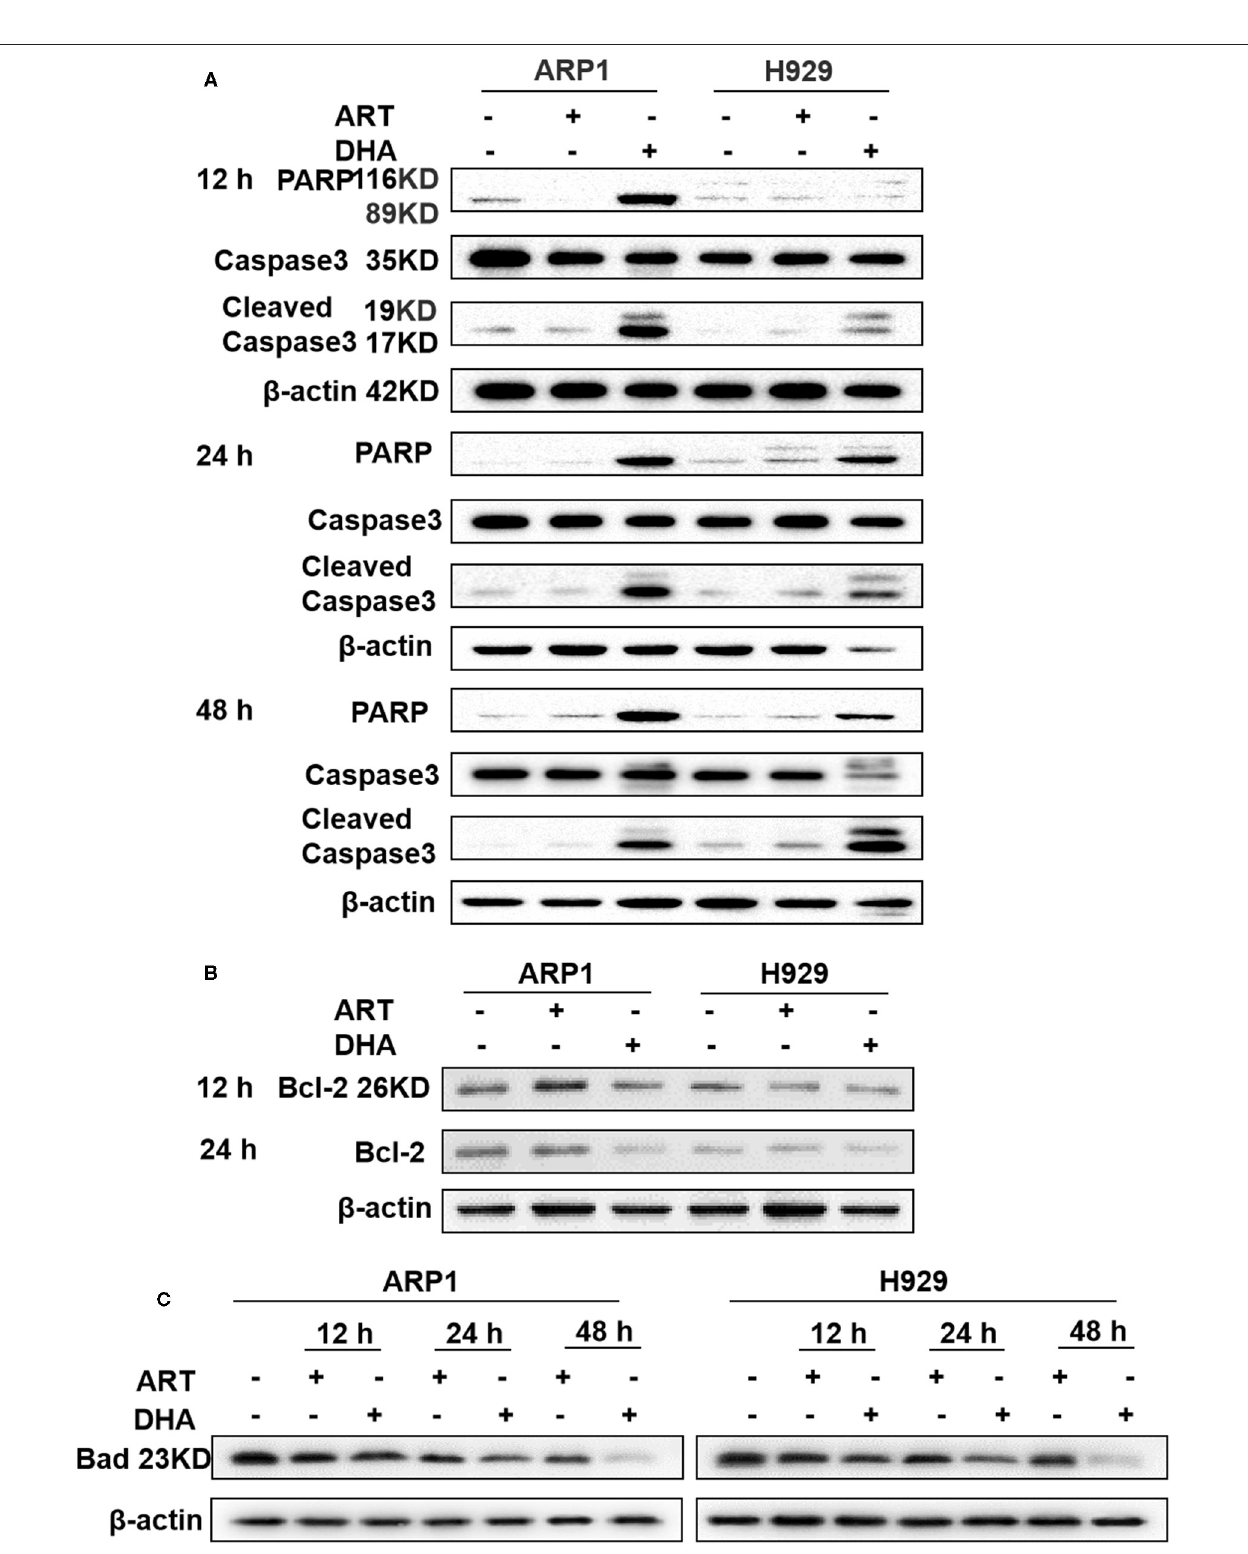
FIGURE 3 | DHA induces caspase-mediated apoptosis in MM cell lines. (A–C) The protein levels of caspase-3, PARP, Bcl-2, and Bad were determined by western blotting in MM cells. The results showed that caspase-3 and PARP were increased after 12h, while Bcl-2 and Bad were decreased after 12h.